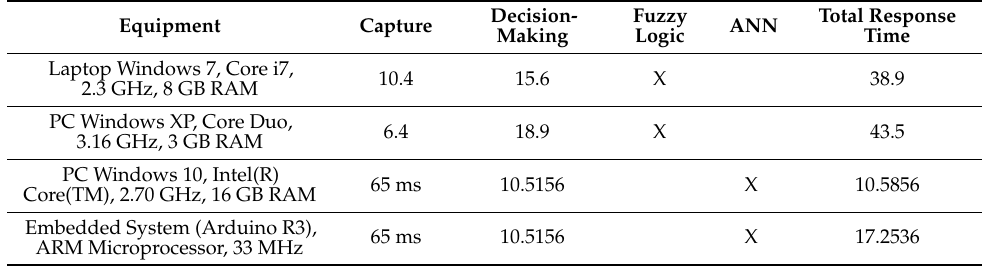
Table 3. Average execution times